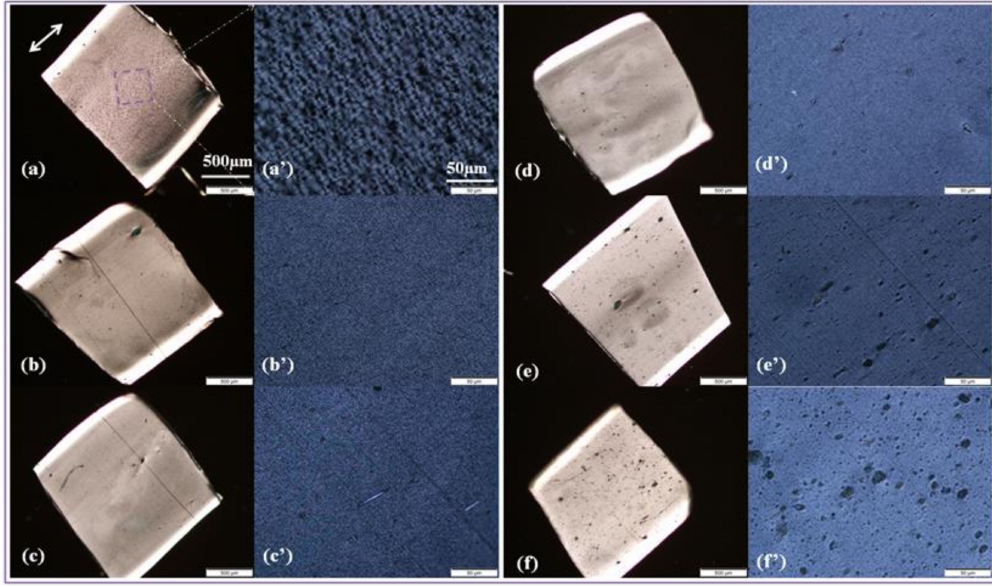
Figure 6. Representative POM images for OBC/DMDBS mini-injection molded samples with different contents of DMDBS. ( a ) OBC; ( b ) D0.25; ( c ) D0.5; ( d ) D1; ( e ) D2.5; ( f )